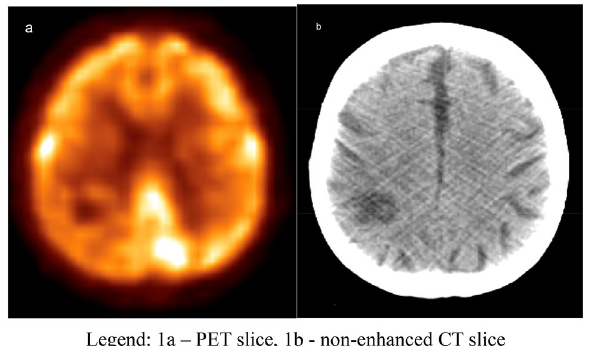
Figure 1. 54 y.o. patient scanned with the [18F]FDG PET/CT (CUP syndrome). Abnormal finding within the right parietal lobe showing a lesion with decreased [18F]FDG uptake surrounded by the brain tissue oedema ( source : original figure; software—Philips Fusion Viewer). ( a ) PET slice, ( b ) non-enhanced CT